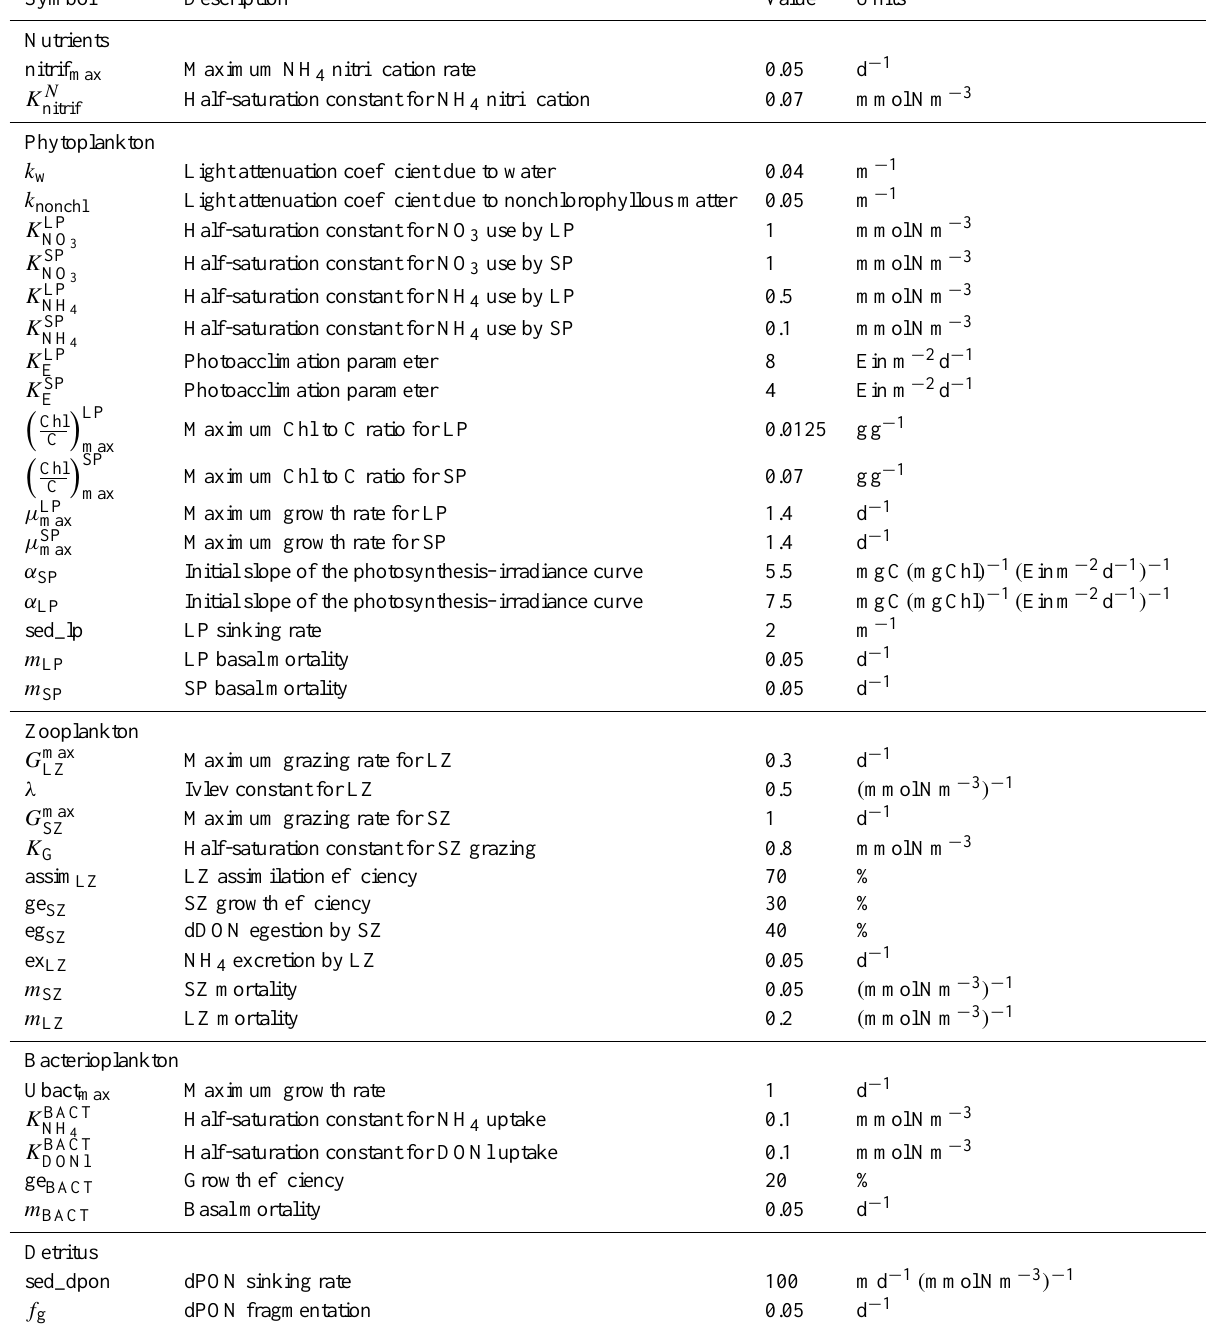
Table 2. Biogeochemical model parameters.